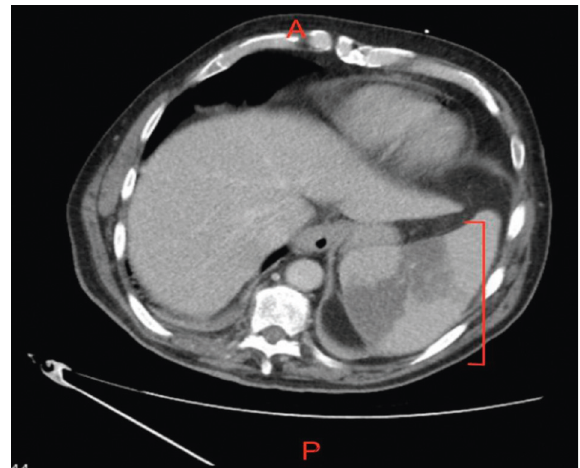
Figure 1: Axial CT abdomen and pelvis imaging showing an enlarged spleen with evidence of acute segmental infarction with well-defined